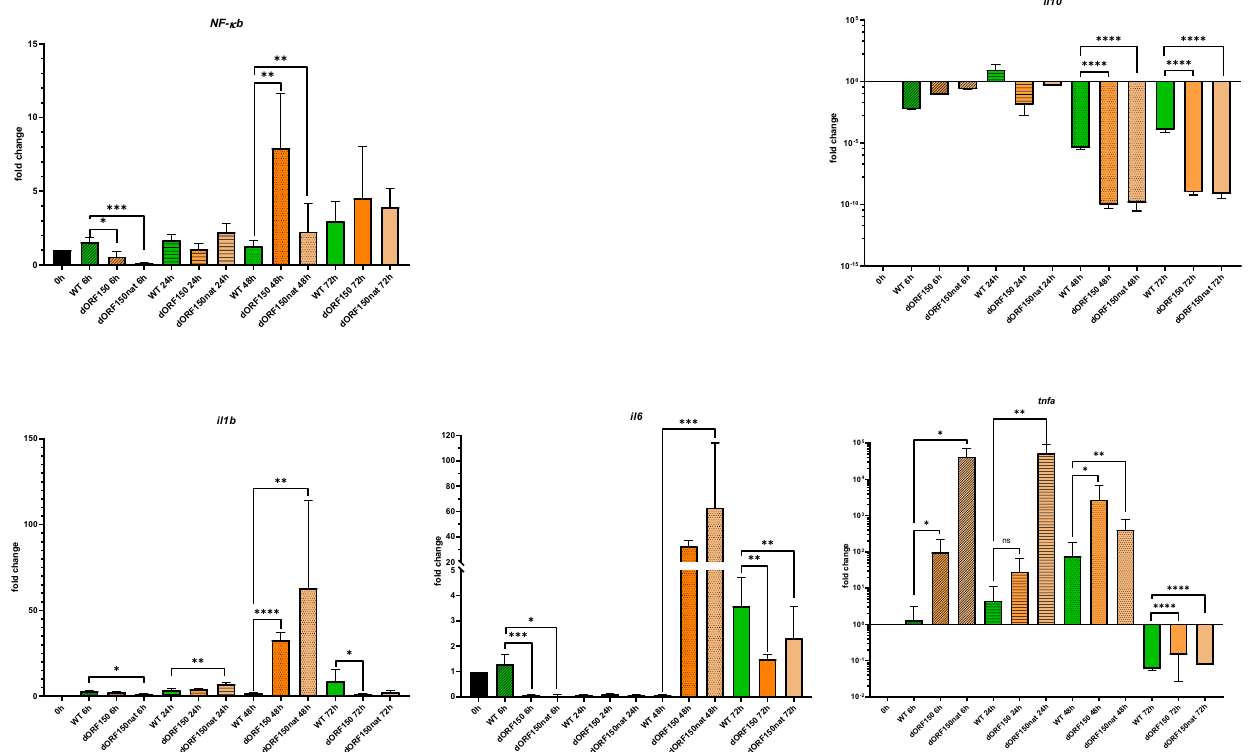
Fig. 6 Expression pro fi le of certain host genes. mRNA expression pro fi le of affected genes in CCB cells after KHV infection. Green bars represent wildtype KHV infection, orange bars represent Δ ORF150 KHV infection and pale orange bars represent Δ ORF150nat KHV infection. All samples were prepared as triplicates. Expression pro fi le was measured by q-RT-PCR using SYBR Green. Data are normalized to actb and rps11 expression levels. Error bars represent standard deviation. ns: not signi fi cant, * p ≤ 0.05, ** p ≤ 0.01, *** p ≤ 0.001, **** p ≤ 0.0001, signi fi cance test: students